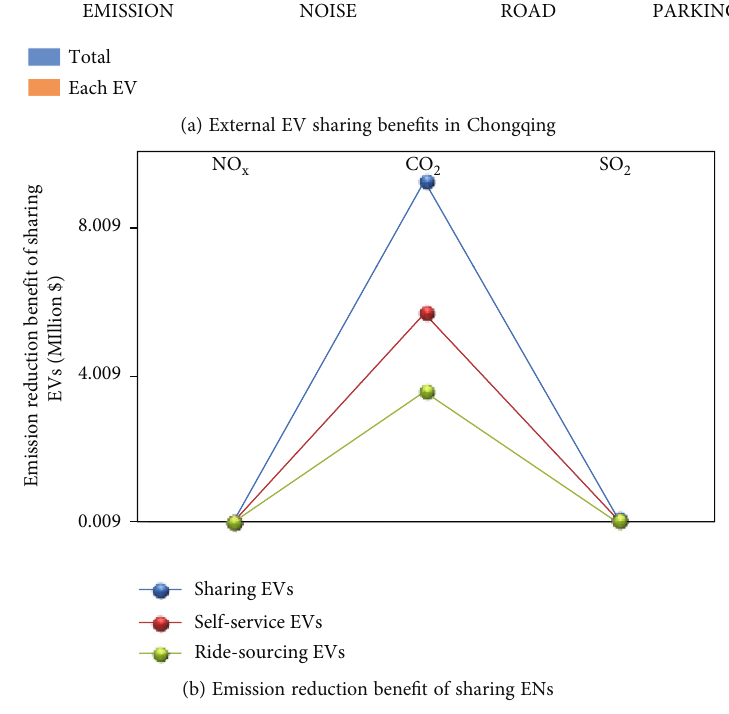
Figure 18: EV sharing bene fi ts